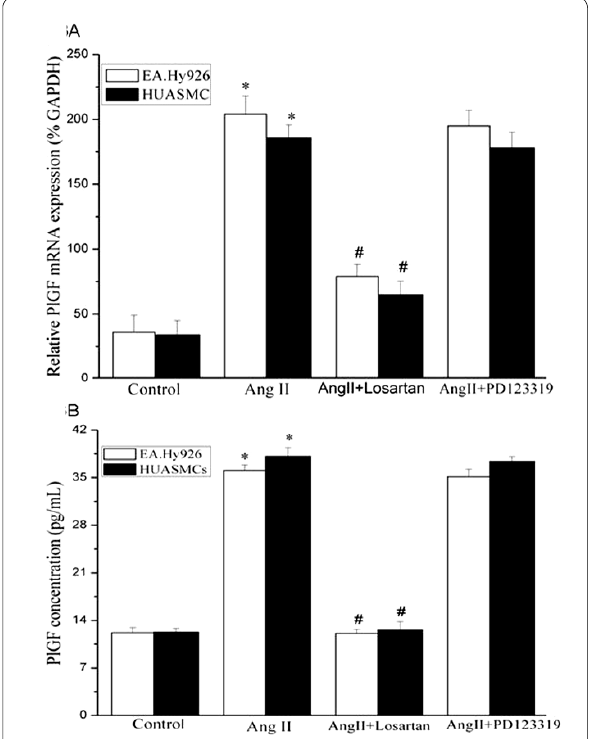
Figure 3 Angiotensin II induces PlGF mRNA (A) and protein levels (B) via AT 1 in EA.Hy 926 endothelial cells and HUASMCs . Cells were pretreated for 30 min with 10 -6 mol/L Losartan (AT 1 R antagonist) or -6 mol/L PD123319 (AT 2 R antagonist) and then stimulated with 10 -6 mol/ L Ang II for 24 hours. (A) Q-PCR results: PlGF mRNA expression was as- sayed by Q-PCR. Experiments were performed five times with the sim- ilar results (n = 5 in each group). * indicates P < 0.05 vs control EA.Hy 926 cells or HUASMCs. # indicates P < 0.05 vs cells treated with Ang II. (B) PlGF protein production in the cell culture media was measured by ELISA (n = 3 in each group). * indicates P < 0.05 vs control EA.Hy 926 cells or HUASMCs. # indicates P < 0.05 vs cells treated with Ang